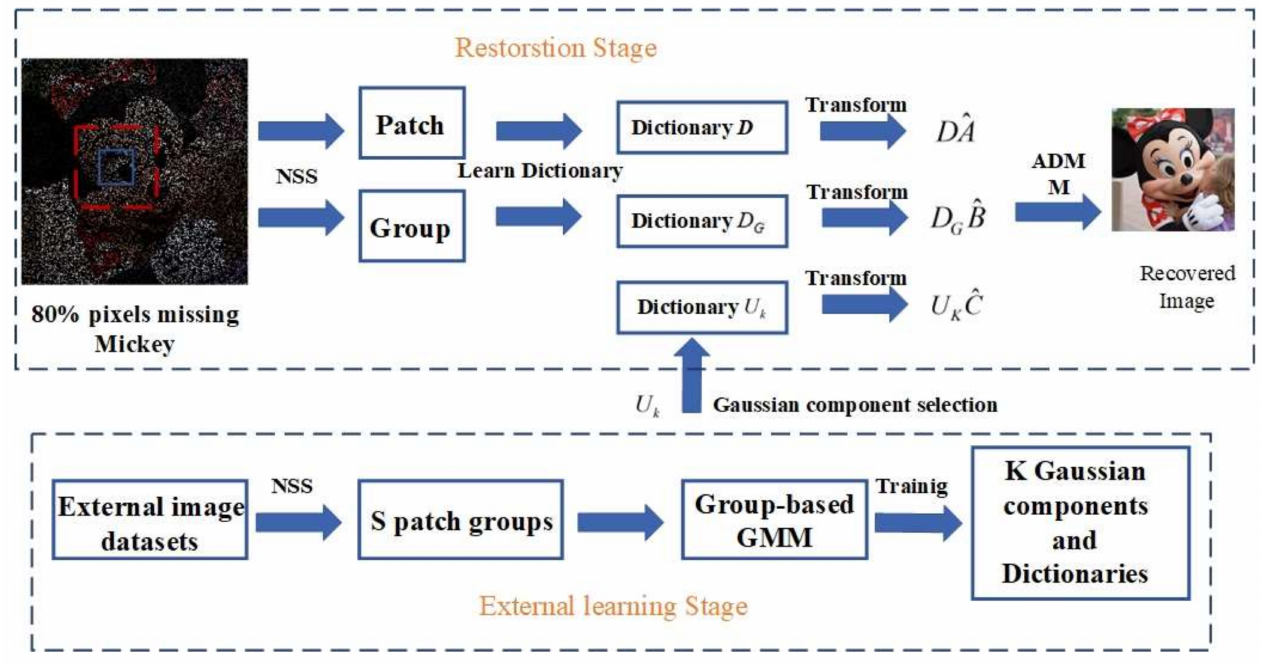
Figure 1. HSR-based image